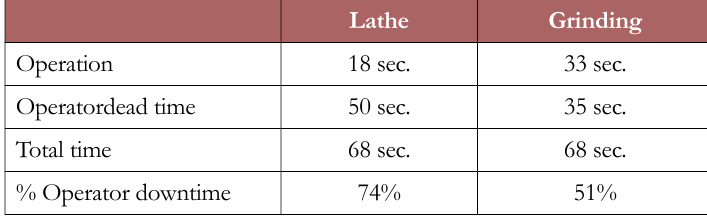
Table 3. Summary of operator